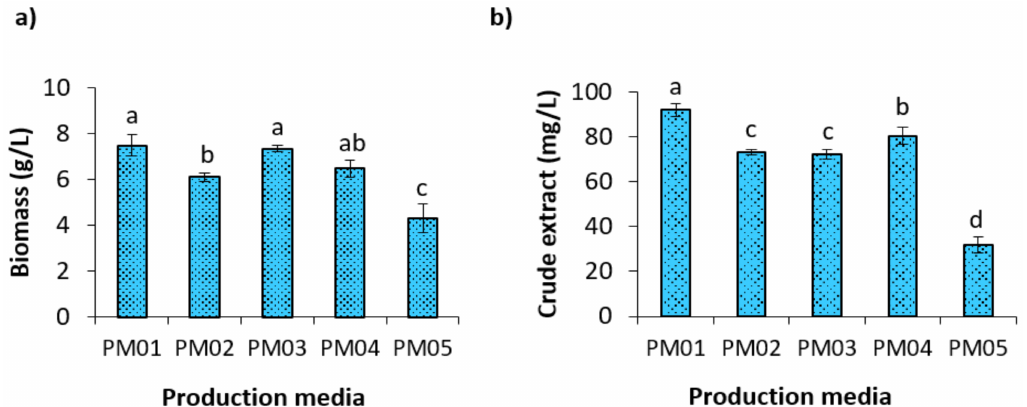
Figure 4. Effect of different production media (PM01 to 5, Table S4) on growth of ( a ) secondary metabolite production ( b ) in Streptomyces sp. SAJ15. Growth was measured as dry mycelial biomass in g L − 1 . Crude extracts were obtained using the standard liquid–liquid extraction method and expressed in mg L − 1 (Mean ± SD). Different lowercase letters across denote statistically significant differences ( p < 0.05